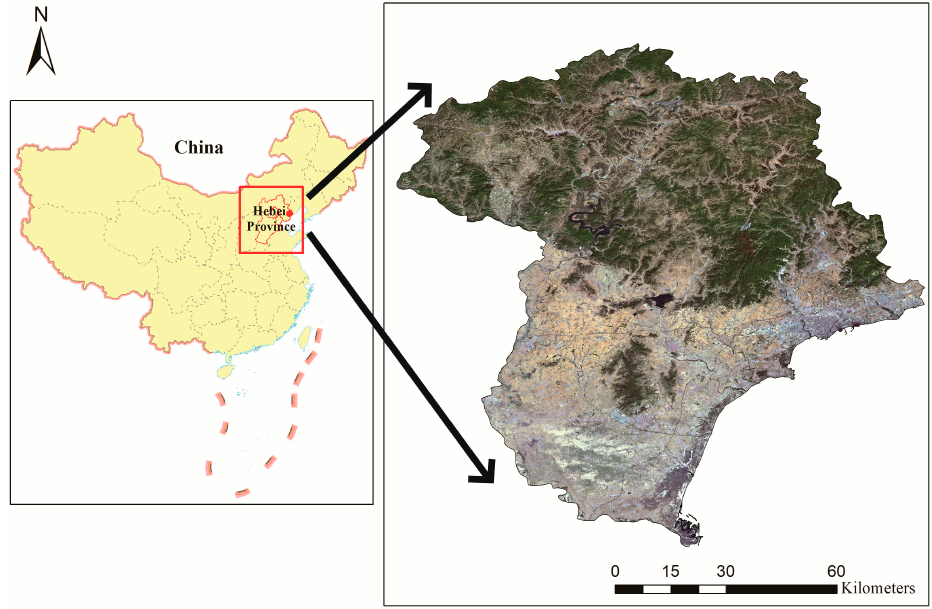
Figure 1 . Study area and image data: Qinhuangdao City Landsat8 (RGB: Bands 4, 3, 2). Figure 1. Study area and image data: Qinhuangdao City Landsat8 (RGB: Bands 4, 3,